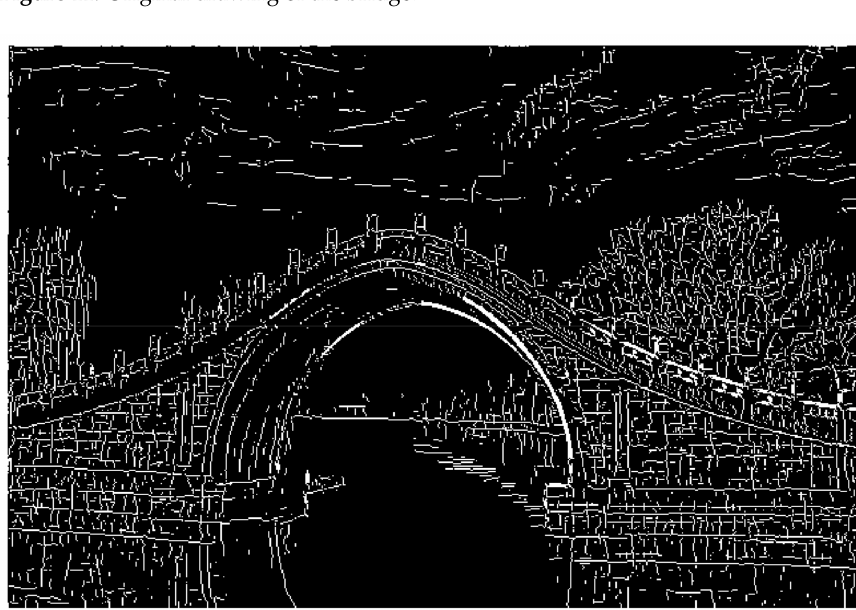
Figure 12. Wavelet transform modulus maxima detection results.